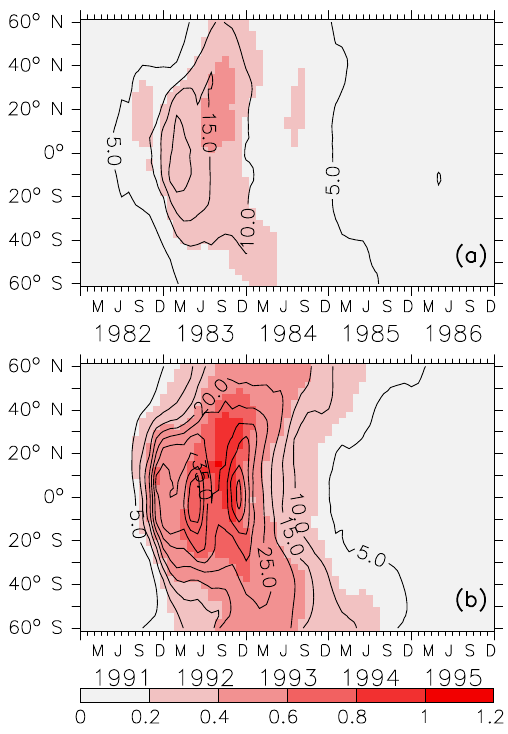
Figure 9. SWV (ppmv, colours) as absolute differences (VOL- NOVOL) zonally averaged near the 90hPa level for (a) the El Chichón period (1982–1986) and (b) the Mount Pinatubo period (1991–1995). Contours indicate relative changes in water vapour (interval 5%) compared to the background value of NOVOL. The small signal seen in 1986 is associated with the November 1985 eruption of Nevado del Ruiz